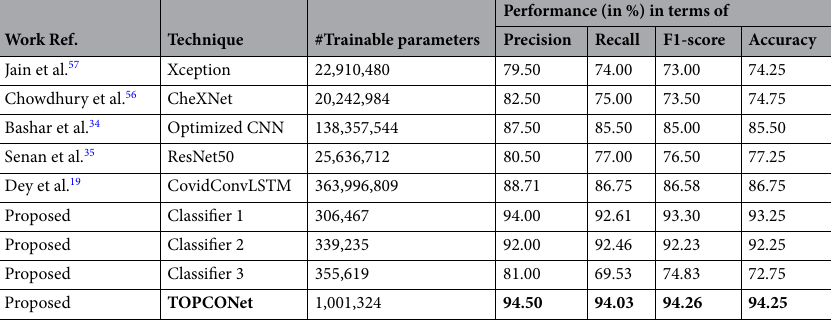
Table 9. Performances of TOPCONet model and its sub-modules along with some state-of-the-art models on COVIDx Dataset. The best values are highlighted in bold.